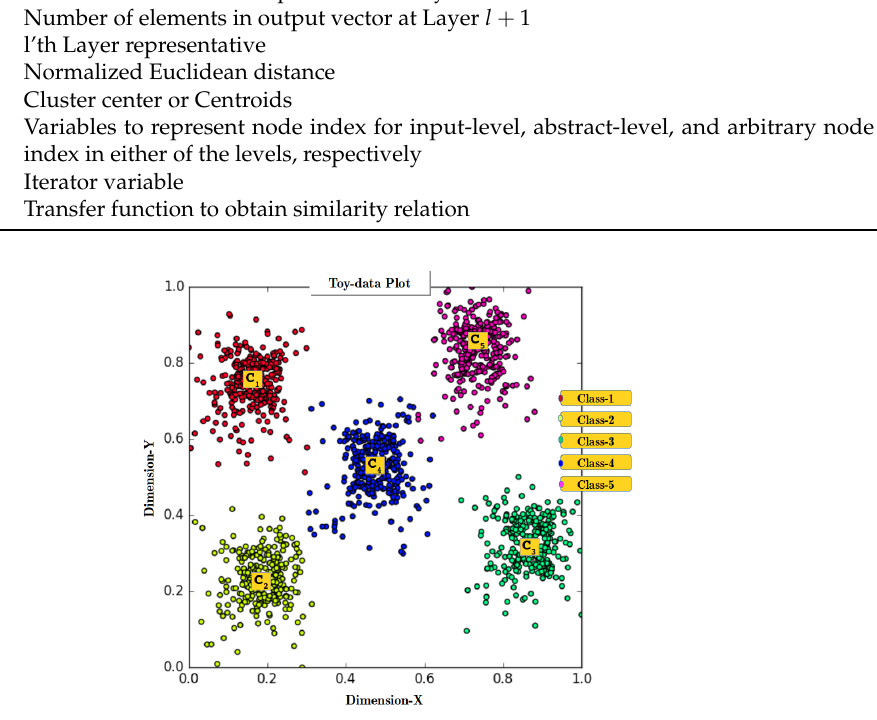
Figure 3. Plot of Toy-data, a 2-D artificially generated data. The plot shows five classes along with their cluster